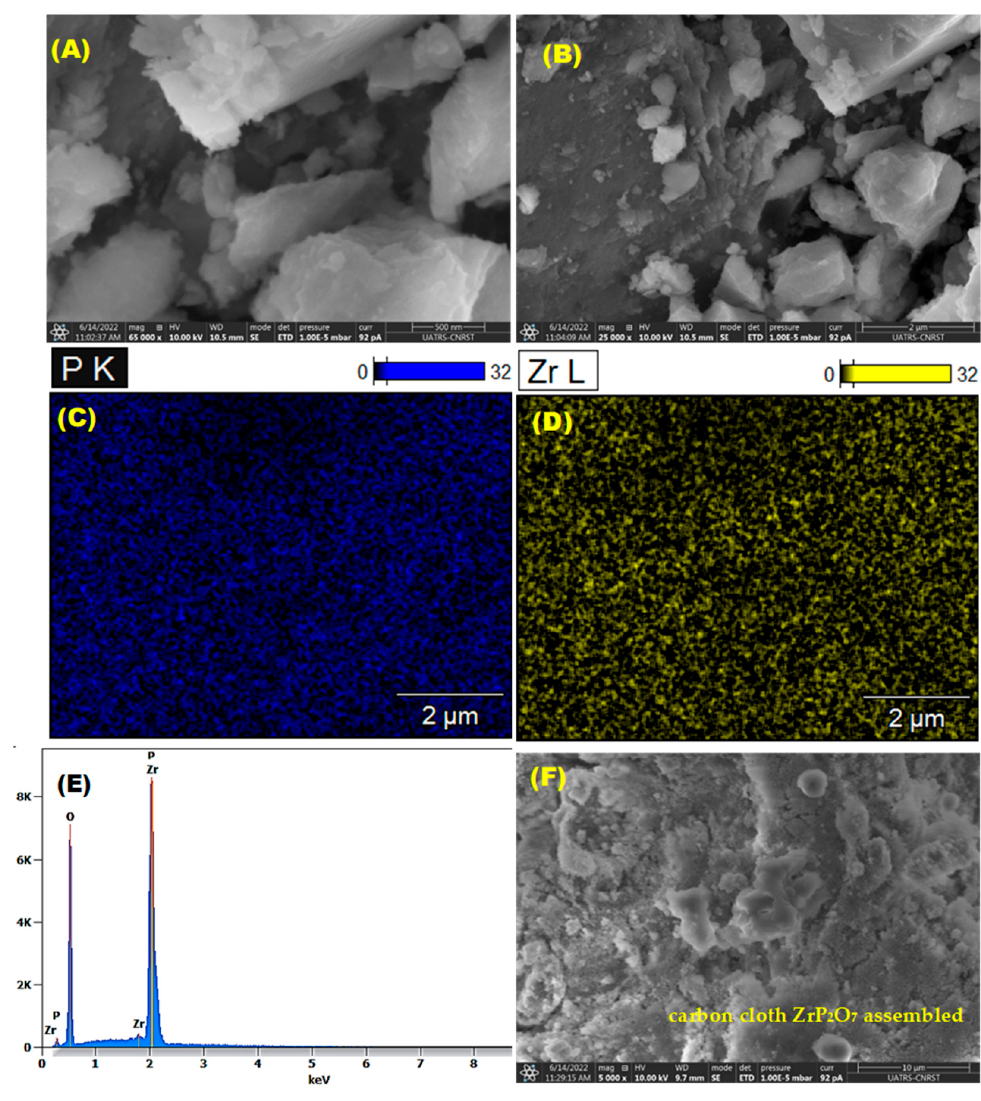
Figure 4. SEM Micrographs ( A , B ), EDX spectral ( E ) and elemental distribution analysis ( C , D ) of ZrP 2 O 7 and carbon cloth-assembled ZrP 2 O 7 ( F Table 1. Composition by EDX analysis.